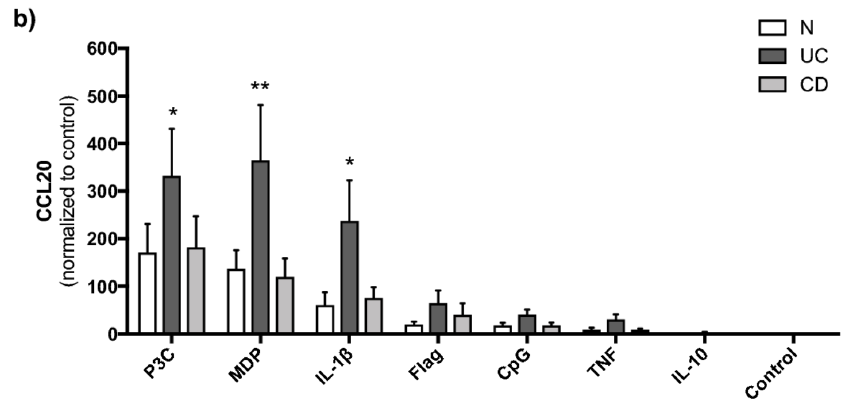
Figure 1. C-C motif ligand 20 (CCL20) release from PBMCs CCL20 (pg/mL) release from PBMCs ( n = 40), following stimulation with lipopeptide Pam3CysSK4 (P3C) (TLR1/2), peptidoglycan component muramyl dipeptide (MDP) (NOD2), unmethylated CpG dinucleotides (CpG) (TLR9), flagellin (TLR5), interleukin (IL) 1 β (IL-1 β ), IL-10 and tumour necrosis factor (TNF). ( a ) CCL20 (pg/mL) release from PBMCs ( n = 40), plotted as median with 95%CI. Statistical comparison was performed using Wilcoxon matched-pairs signed rank test with levels of significance denoted by **** p < 0.0001 versus control, ** p < 0.01 versus control. ( b ) CCL20 release following stimulation normalized to release in control conditions, in PBMCs from healthy controls (N) ( n = 8), ulcerative colitis (UC) ( n = 16) and Crohn’s disease (CD) ( n = 16) patients. Mean with SEM are plotted. Statistical comparison was performed using unpaired t -test with levels of significance denoted by * UC vs. CD p < 0.05, ** UC vs. CD p < 0.01.